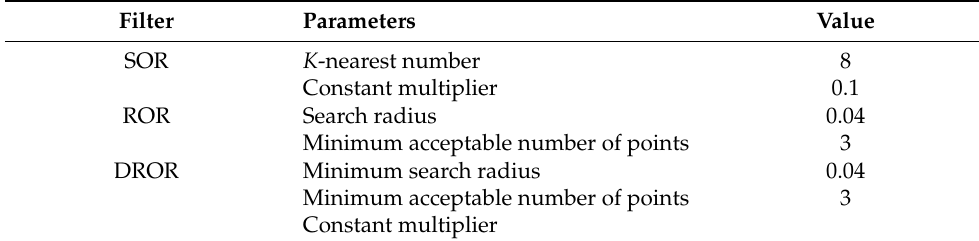
Table 4. Parameters of the SOR, ROR, AND DROR filters.